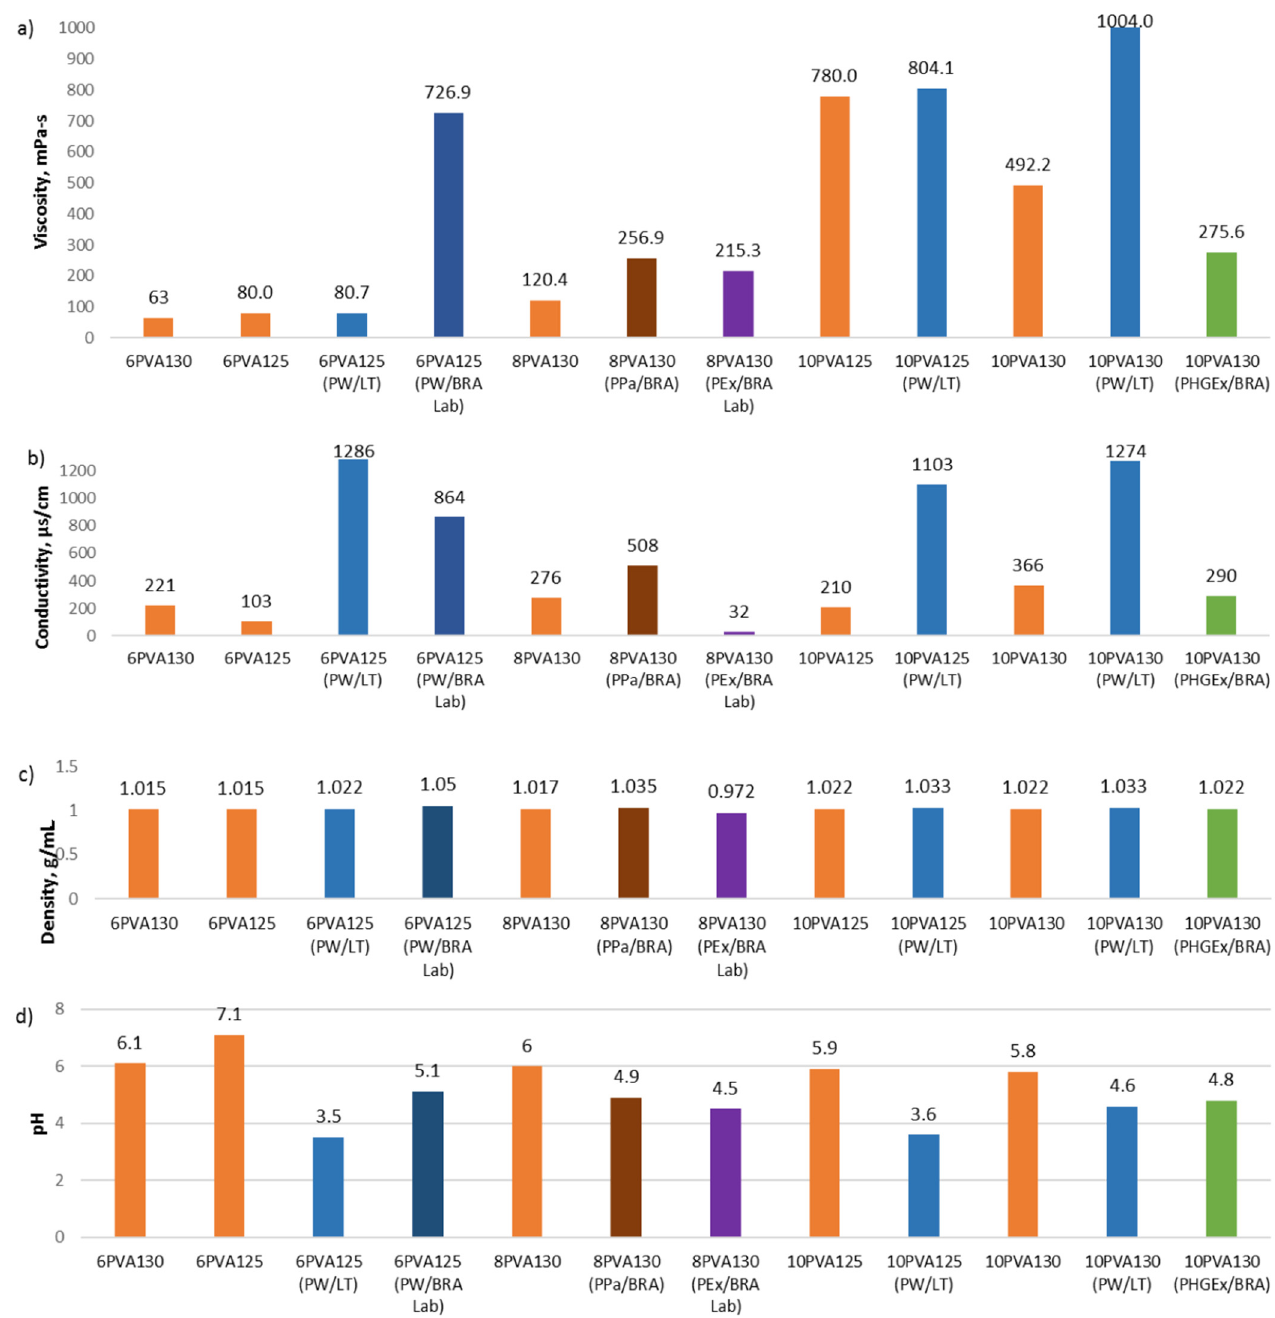
Figure 1. PVA and PVA with propolis water, propolis particles, hydroglyceric, or ethyl alcohol propolis extracts solutions’ properties: ( a ) viscosity, ( b ) conductivity, ( c ) density, and ( d ) pH.